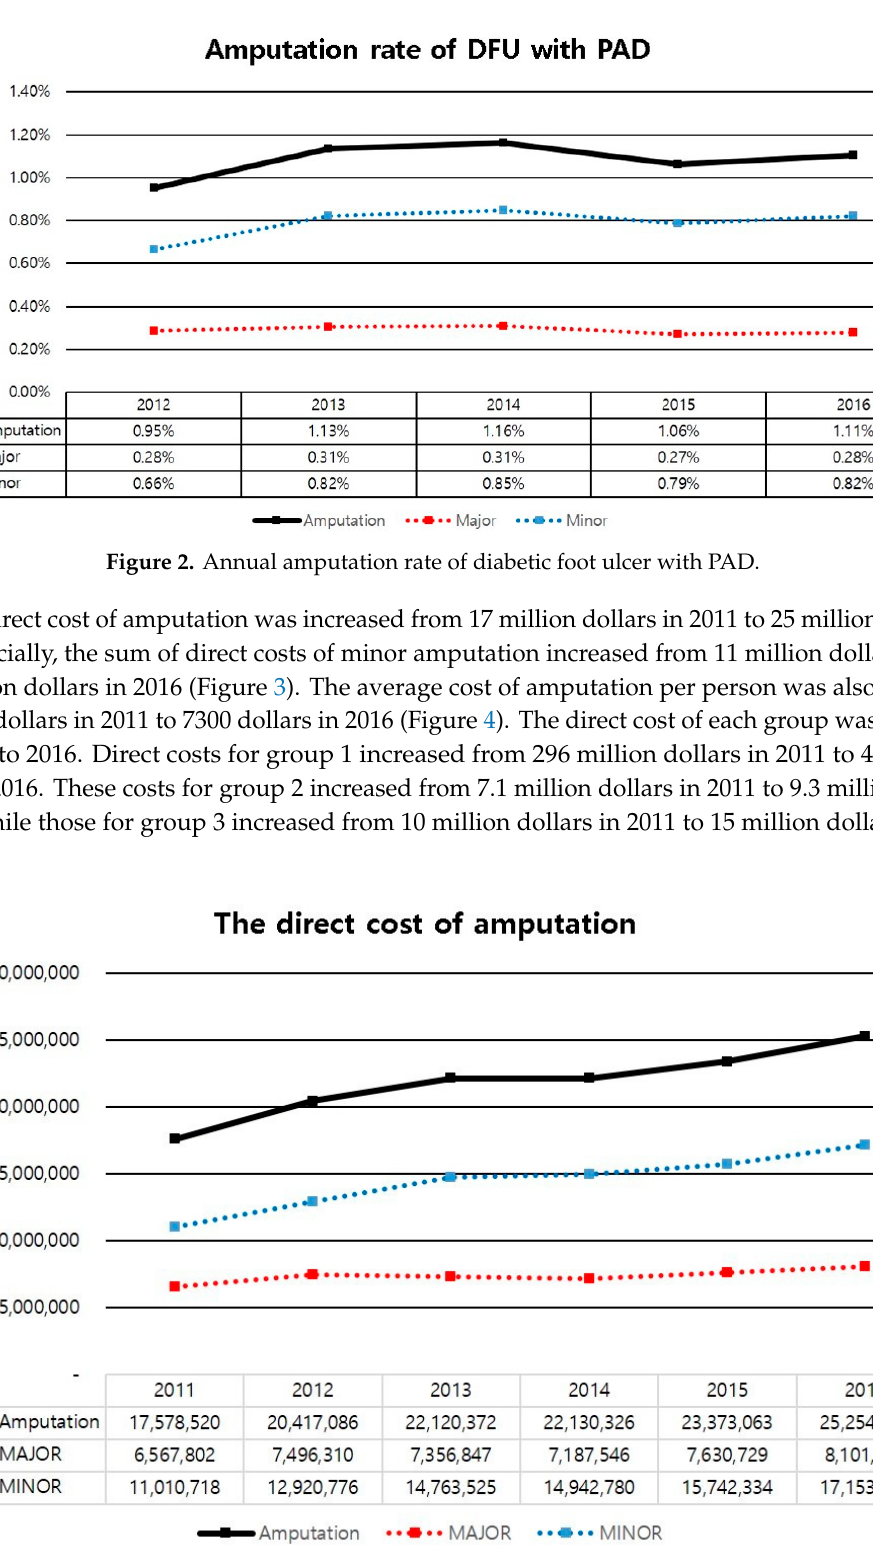
Figure 3. The direct cost of amputation of diabetic foot ulcer with